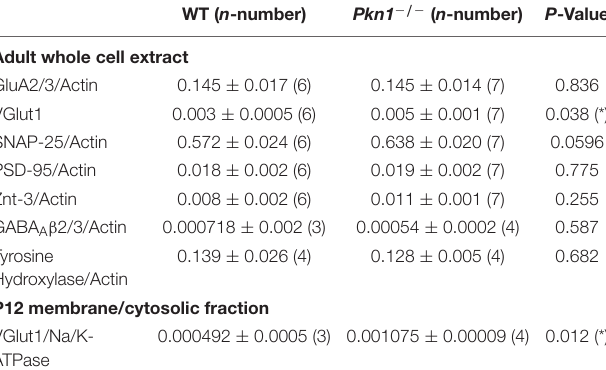
TABLE 1 | Expression levels of synaptic proteins in whole cell, cytosolic, and membrane fractions of P12 and adult animals. WT ( n